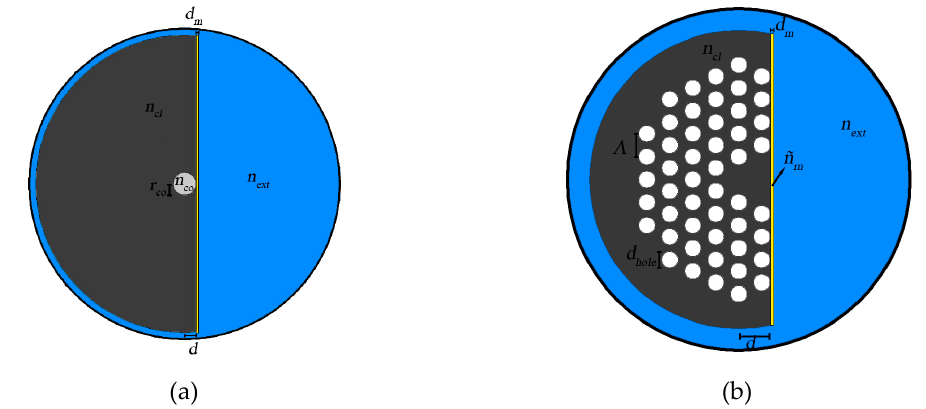
Figure 1. Two SPR D-type fiber configurations: ( a ) conventional and ( b ) PCF. (a) shows the configuration of a conventional D-type optical fiber plasmonic sensor and Figure 1 (b) shows the configuration of PCF D-type optical fiber plasmonic sensor, composed by a core with refractive index